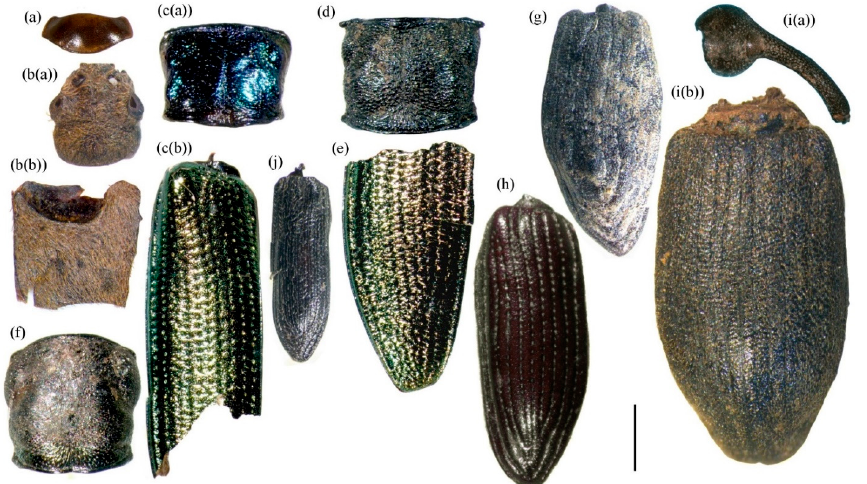
Figure 12. Remains of insects from riparian vegetation: ( a )— Cyphon variabilis ; ( b )— Donacia sp.; ( c )— Donacia crassipes ; ( d )— D. splendens ; ( e )— D. semicuprea ; ( f )— Plateumaris sericea ; ( g )— Grypus equiseti ; ( h )— Notaris aethiops ; ( i )— N. bimaculatus , ( j )— Limnobaris dolorosa ; ( a , b , f , j ) Peschanaya Gora, Holocene, ( b ) Ulakhan-Sullar, late Pleistocene; ( d ) Kyzyl-Syr, late Pleistocene (MIS3) peat; ( g )—Ust-Buotama, Holocene, ( h , i ( a )) Lucky Lady: ( h ) Holocene, ( i ( a )) late Pleistocene (MIS 5); ( i ( b )) Ulakhan-Sullar, middle Pleistocene.